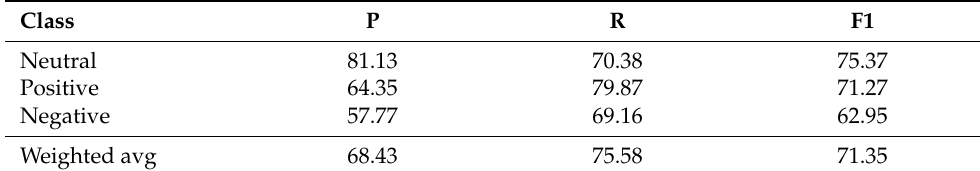
Table 9. Performance of sentiment classifier using